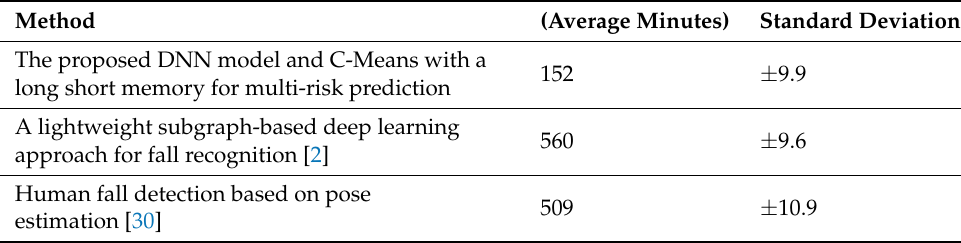
Table 12. Training CPU time of training of all